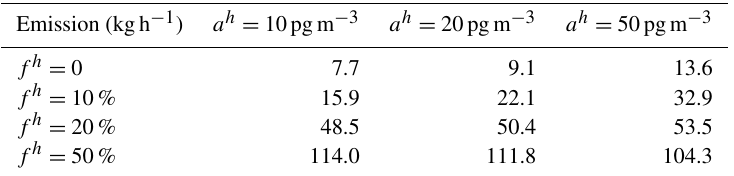
Table 4. Emission strength of release 2 that minimizes F for different f h and a h . Concentration is taken as the metric variable. (cid:15) 2 = (f o × c o + a o ) 2 + (f h × c h + a h ) 2 . f o = 20%, a o = 20pgm − 3 .